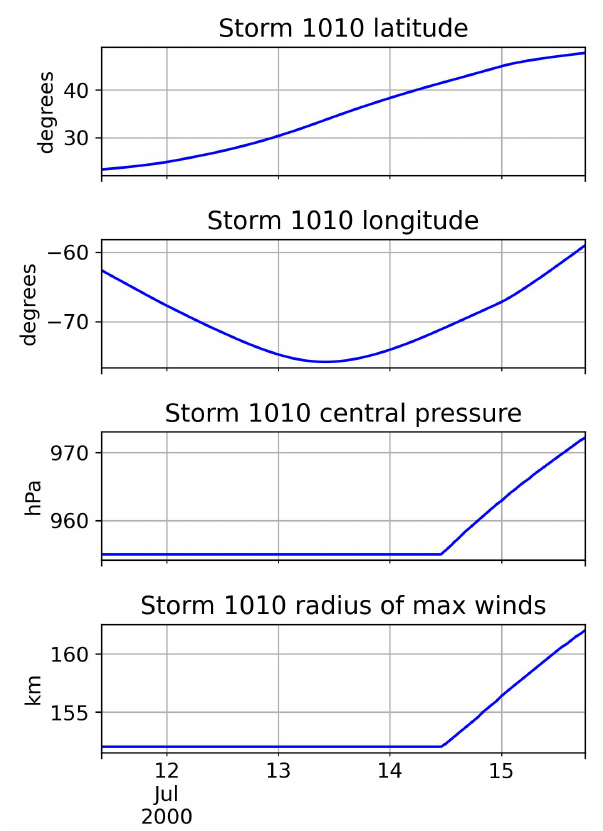
Figure 10. The time-series profiles of storm center (i.e., longitude and latitude), the central pressure, and the radius of the maximum winds of the bypassing storm